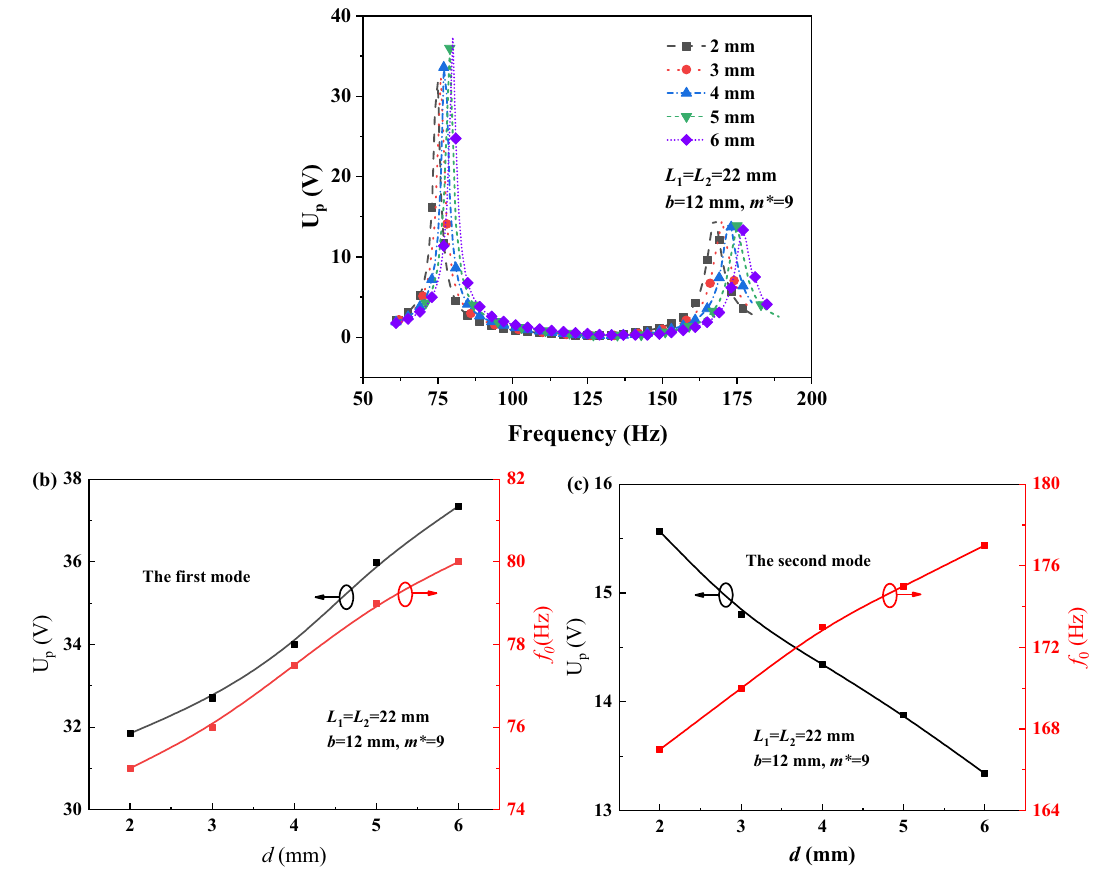
Figure 5. The U p - f curves ( a ), U p-max and f 0 vs m * curves at the first ( b ) and second ( c )